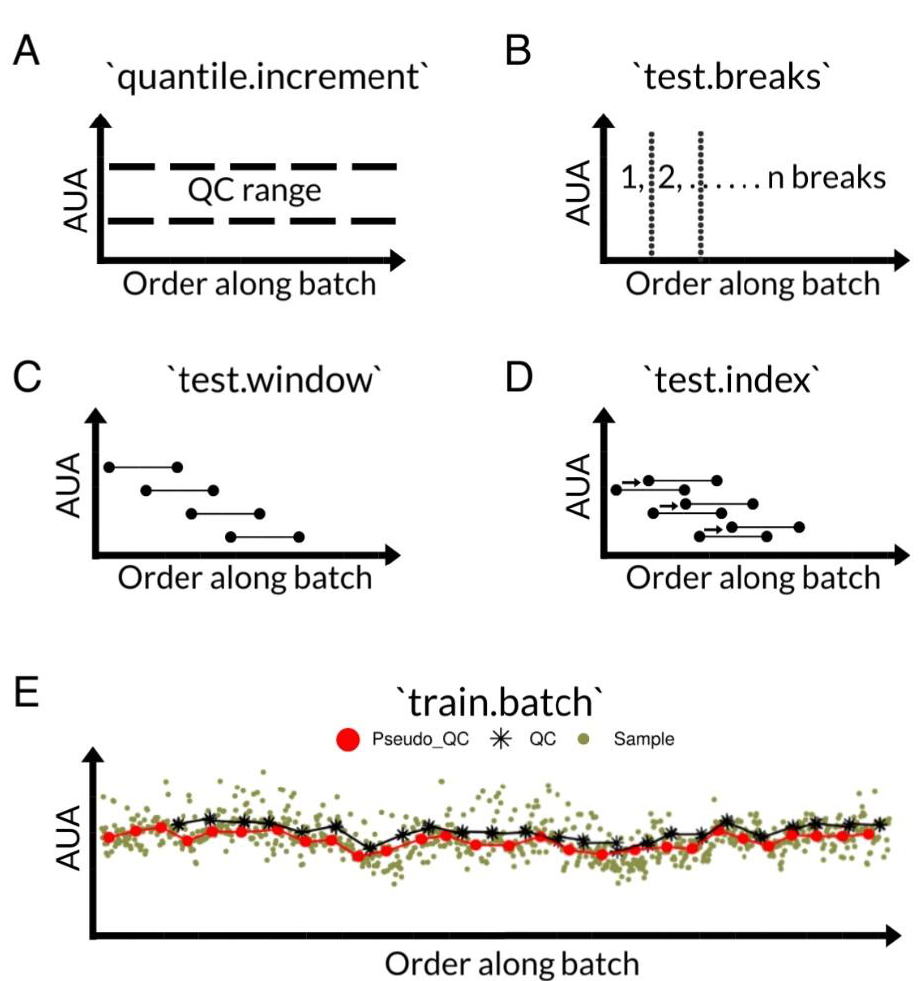
Figure 3. The parameters ( A – D ) optimized for ‘pseudo_sdc()’ that minimize the criteria set by the user. The parameter name is given in the title of each plot, and all computations are made using arbitrary units of area (AUA). By default, the mean squared error is minimized between estimated pseudoQC and true QC samples in the training batch ( E ).